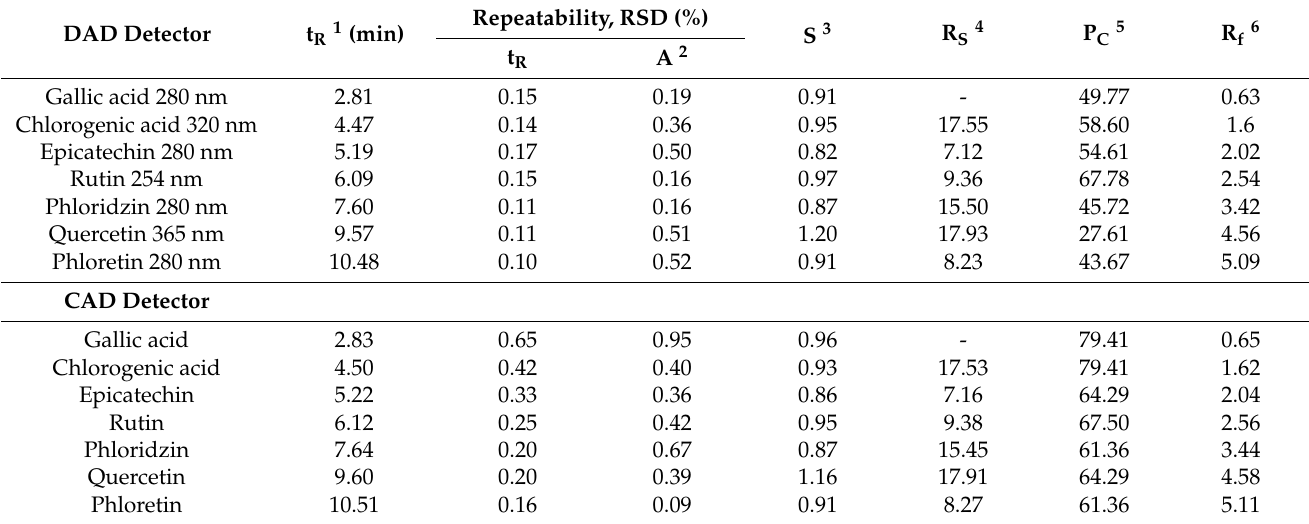
Table 1. System suitability test (n = 6) of the elution of phenolic compounds detected using diode-array (DAD) and charged aerosol (CAD). Separation conditions: gradient elution with mobile phases aqueous acetic acid with pH 2.8 (A) and acetonitrile (B), gradient profile 10–50% B in 10 min, 50% B 0.2 min, 50–10% B in 2.3 min, column temperature 30 ◦